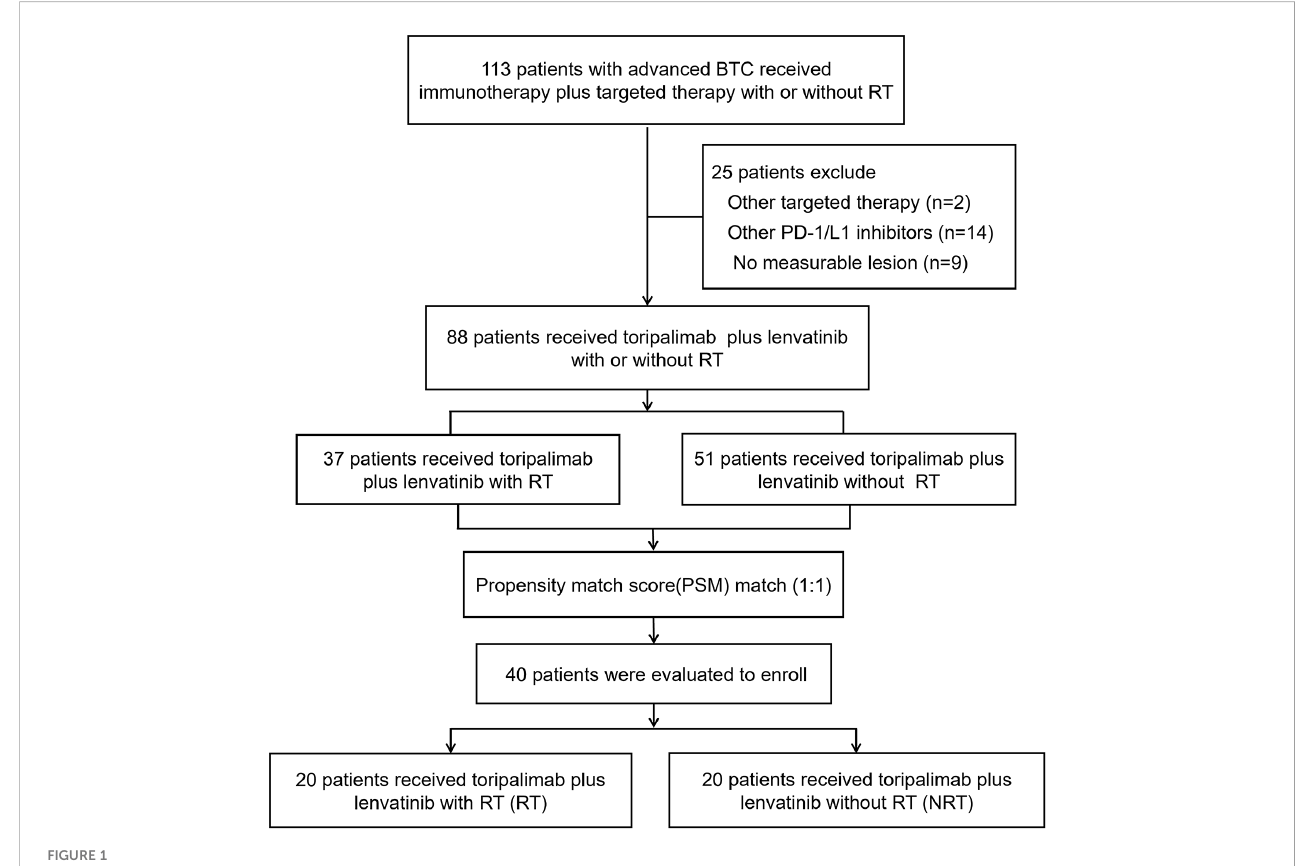
FIGURE 1 Study work fl